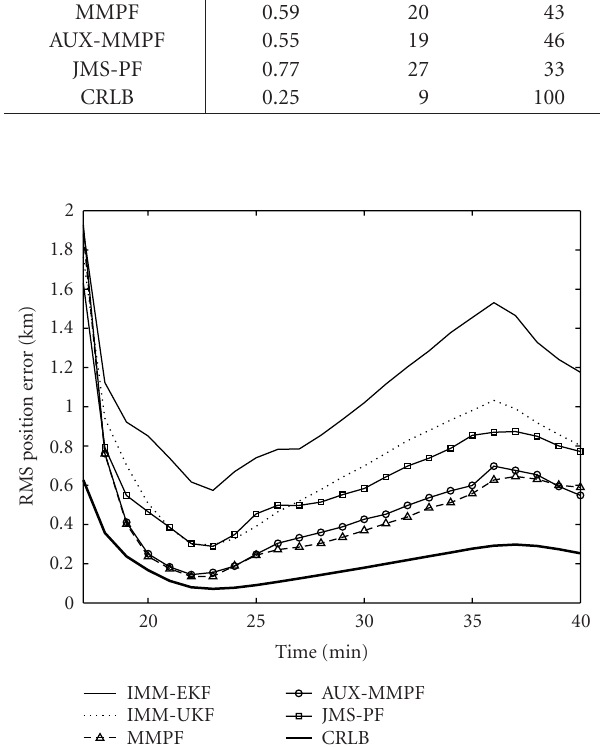
Figure 2: RMS position error versus time for a manoeuvring target